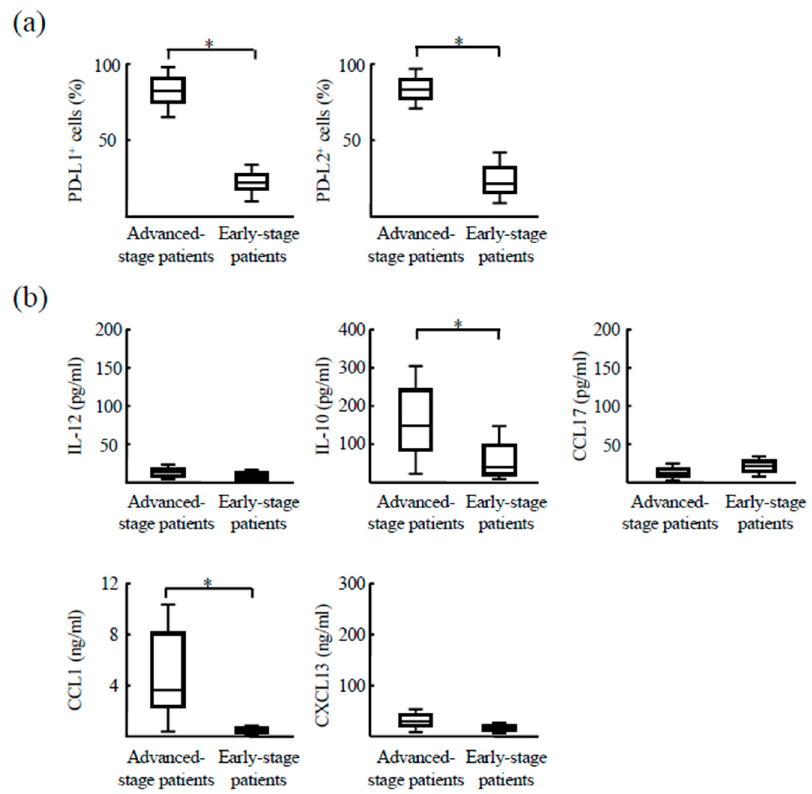
Figure 3. Changes in CD14 + cell properties related to treatment-induced tumor regression in patients with advanced-stage HCC. ( a ) CD14 + cells were isolated from patients with advanced HCC before treatment initiation and after tumor regression ( n = 5). CD14 + cells were stained with anti-PD-L1 and anti-PD-L2 antibodies and assayed by flow cytometry. ( b ) CD14 + cells were cultured for 24 h, and their culture media was analyzed by ELISA for IL-12, IL-10, CCL17, CCL1, and CXCL13 detection. * p < 0.05.